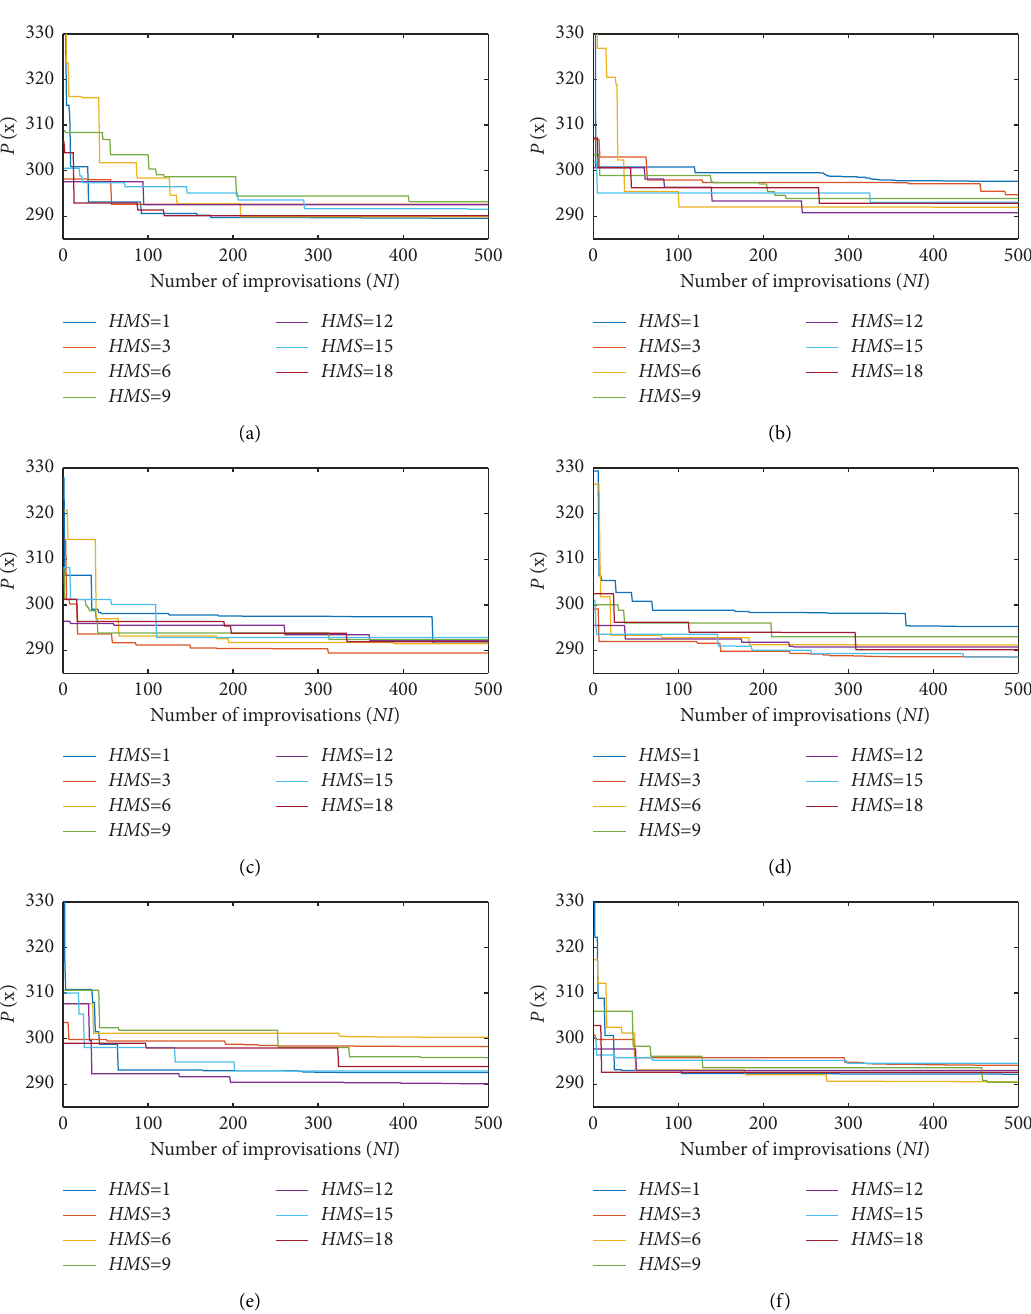
Figure 6: Convergence curve of objective function, 􏽢 P ( x ) , for HMCR: (a) 0.70, (b) 0.75, (c) 0.80, (d) 0.85, (e) 0.90, and (f)